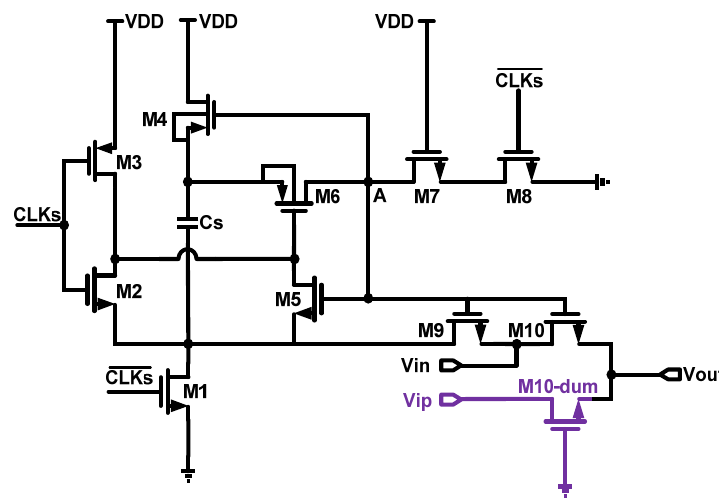
Figure 12. Bootstrapped switch.